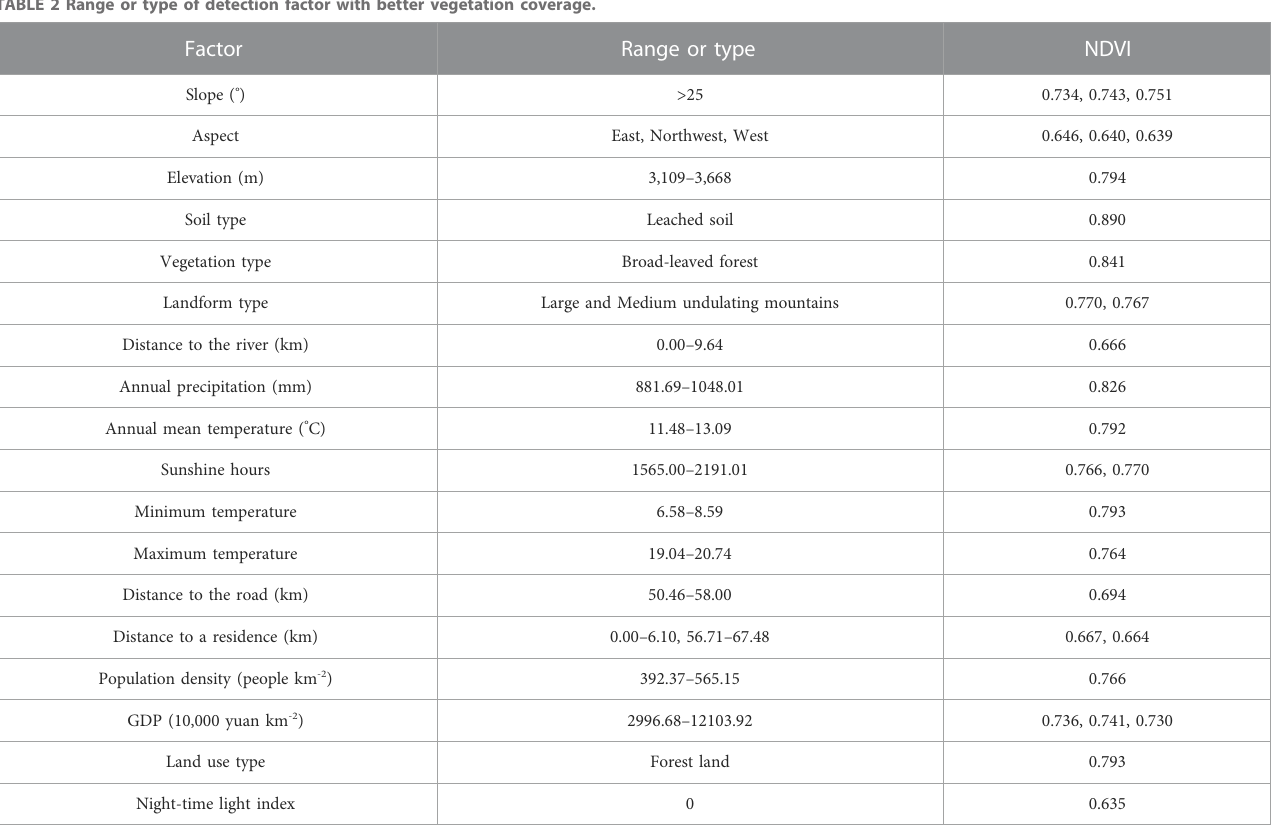
TABLE 2 Range or type of detection factor with better vegetation